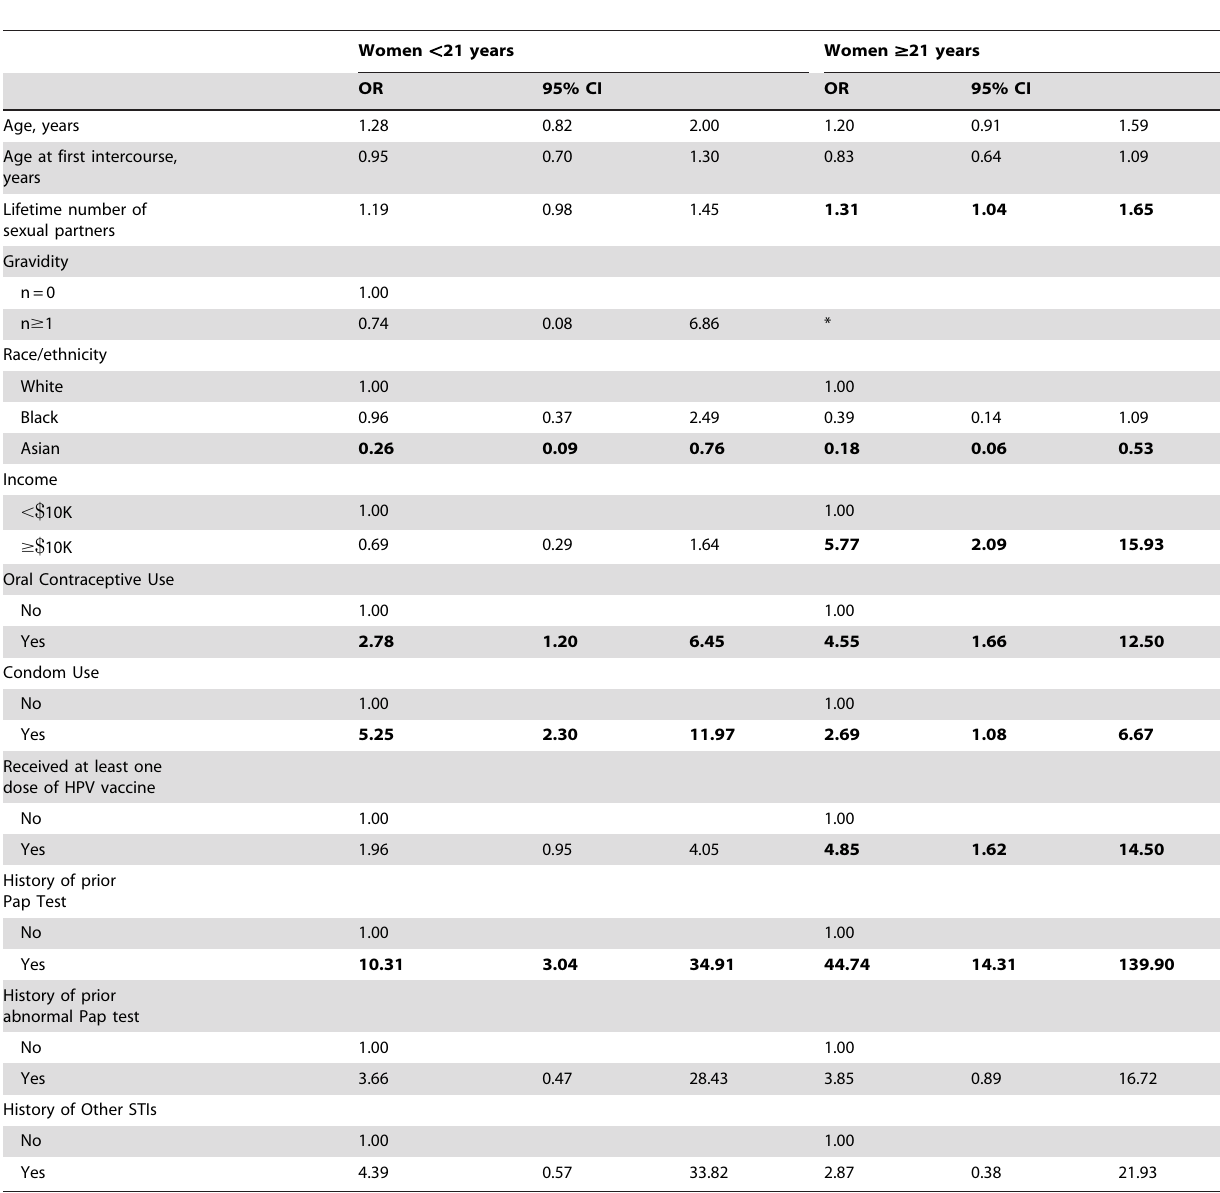
Table 2. Univariate predictors of positive intent to participate in cervical cancer screening by age group by